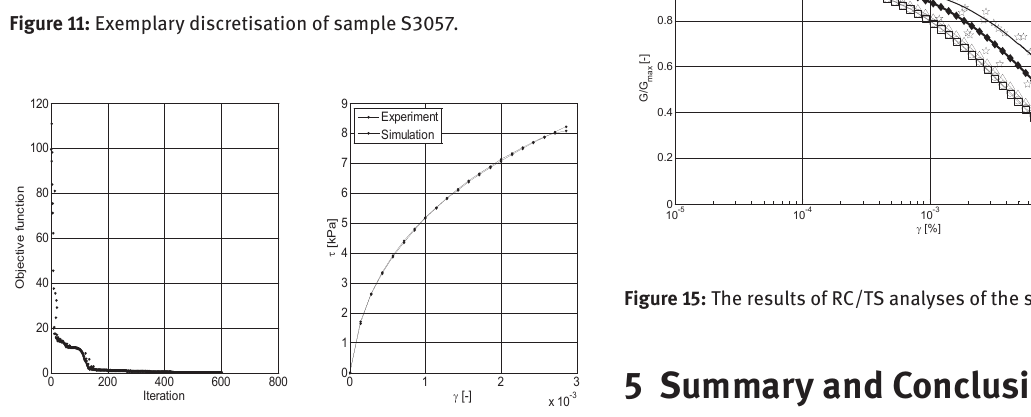
Figure 12: Exemplary results of back analysis of sample S3057. Fig. 12. Exemplary results of back analysis of sample S3057.